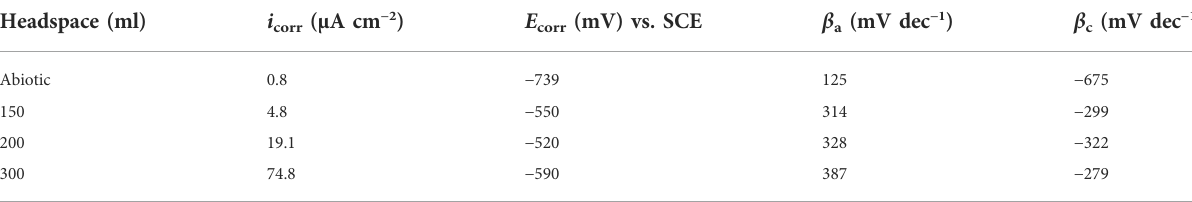
TABLE 3 Fitted electrochemical parameters from Tafel analysis at the end of the 14-day incubation in Figure 7. Headspace (ml)